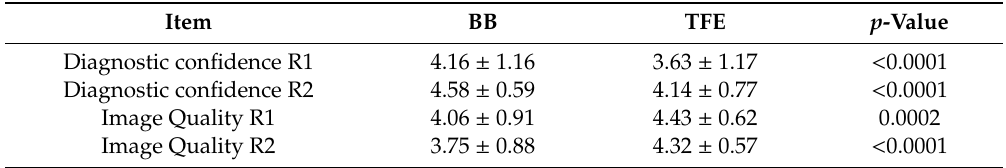
Table 1. Image quality and diagnostic confidence to detect contrast-enhancing tumor residuals for all included patients ( n = 73 patients).